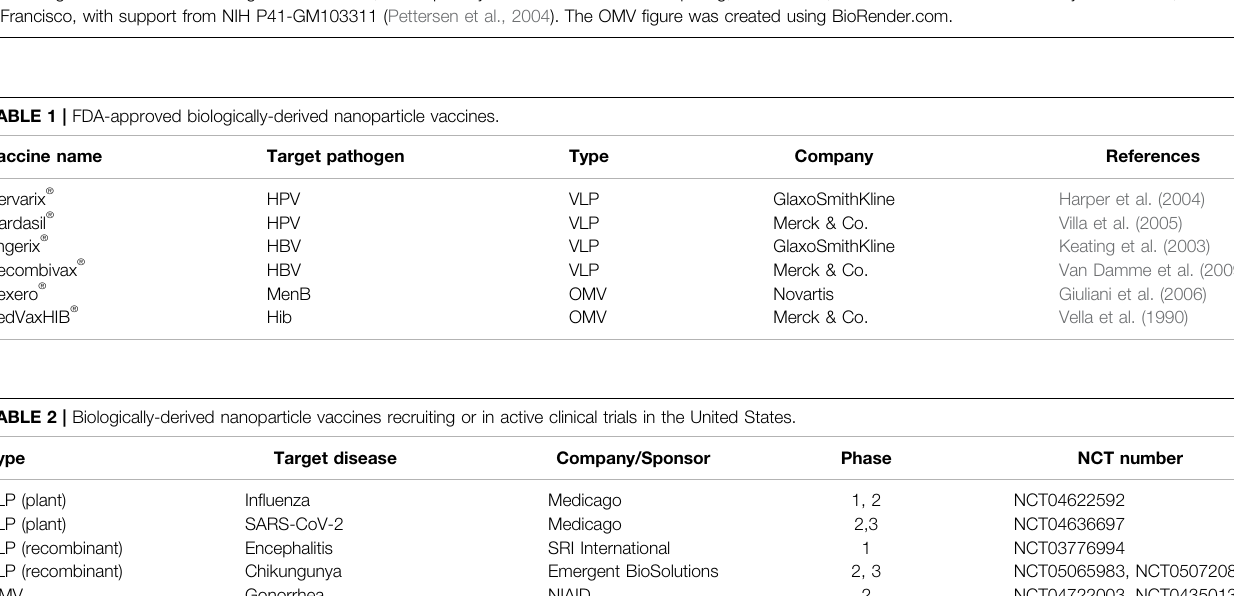
FIGURE2| Biologically-derivedvaccineplatformshighlightedinthisreview.Virus-likeparticles(VLPs),outermembranevesicles(OMVs),andproteincages(ferritin) have been studied extensively as vaccine platforms (left). These biological nanoparticles may be formulated into higher order structures (right) to increase their stability and adjuvanticity, as well as enabling controlled release for use as single-dose vaccine platforms. MS2 bacteriophage was used as a model for the VLP (pdb id. 2MS2 (Golmohammadi et al., 1993)). For the modeling of the ferritin nanocage, the crystal structure of L-ferritin (pdb id. 2fg8 (Wang et al., 2006)) was used. The VLP and nanocage were constructed using UCSF Chimera, developed by the Resource for Biocomputing, Visualization, and Informatics at the University of California, San Francisco, with support from NIH P41-GM103311 (Pettersen et al., 2004). The OMV fi gure was created using BioRender.com.